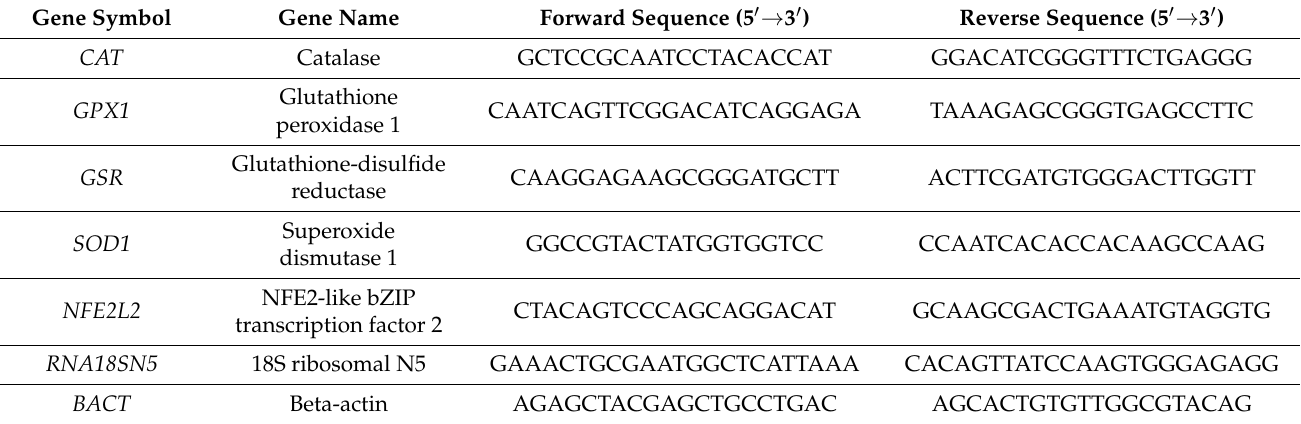
Table 4. qPCR primers used in